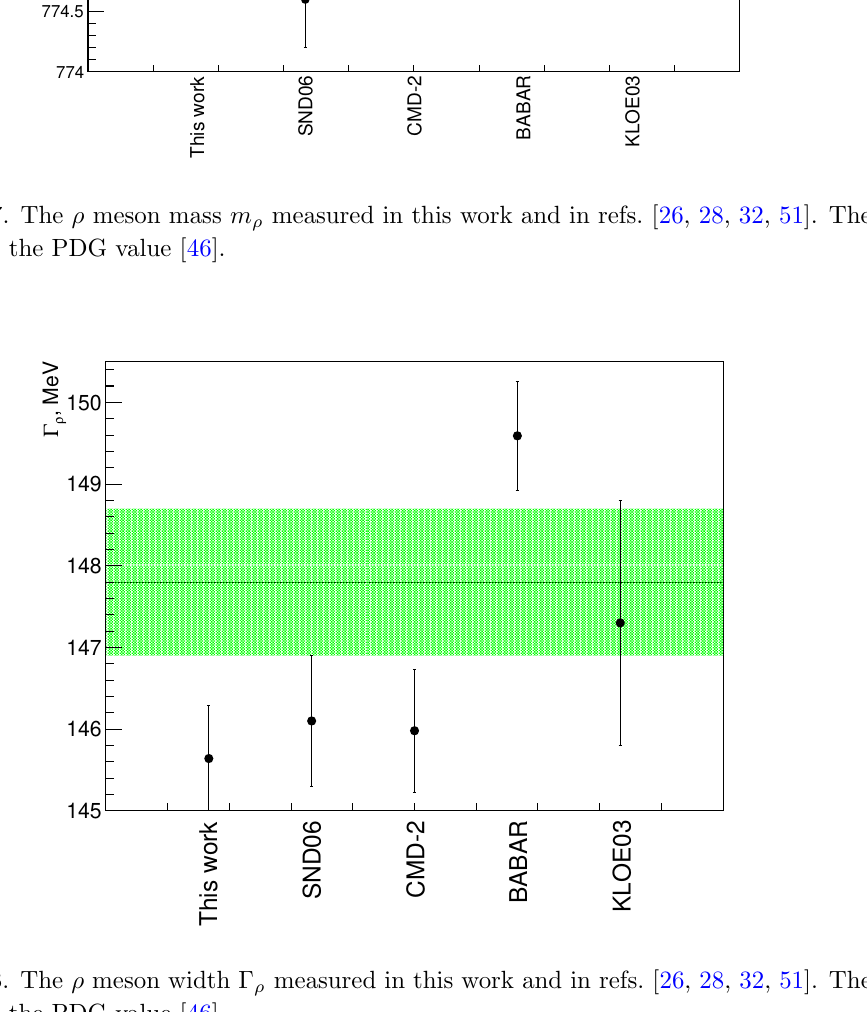
Figure 18 . The (cid:26) meson width (cid:0) (cid:26) measured in this work and in refs. [26, 28, 32, 51]. The shaded area shows the PDG value